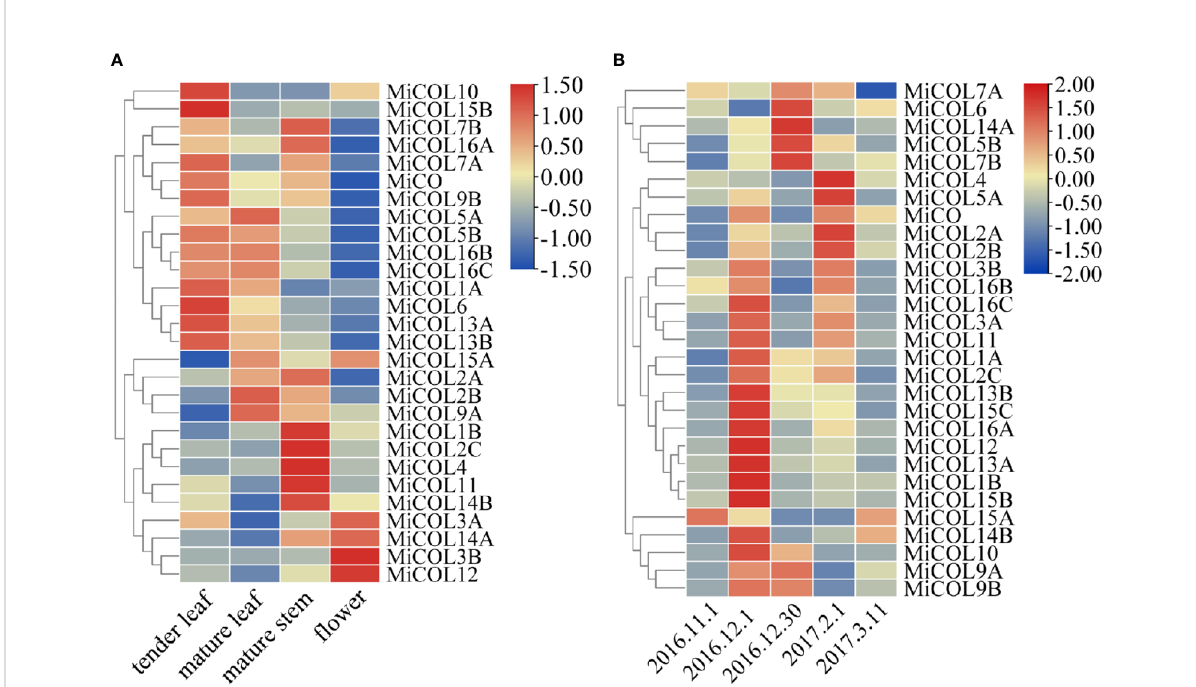
FIGURE 5 Tissue and temporal expression patterns of MiCOL genes in mango. (A) Expression levels in different tissues. (B) Expression levels in different growth periods. Vegetative growth period: November 1, 2016, to December 1, 2016. Floral induction period: December 1, 2016, to December 30, 2016. Floral differentiation period: December 30, 2016, to February 1, 2017. In fl orescence elongation and fl owering period: February 1, 2017, to March 11, 2017. The color gradient (red/yellow/blue) indicates the gene expression level (from high to low).